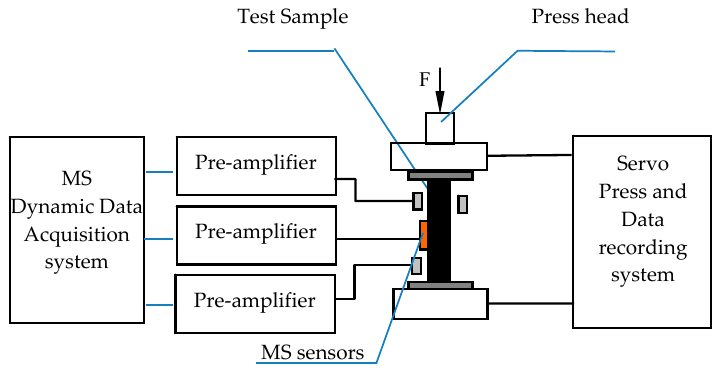
Figure 2. The diagram of the microseismic (MS) test system under uniaxial compression.